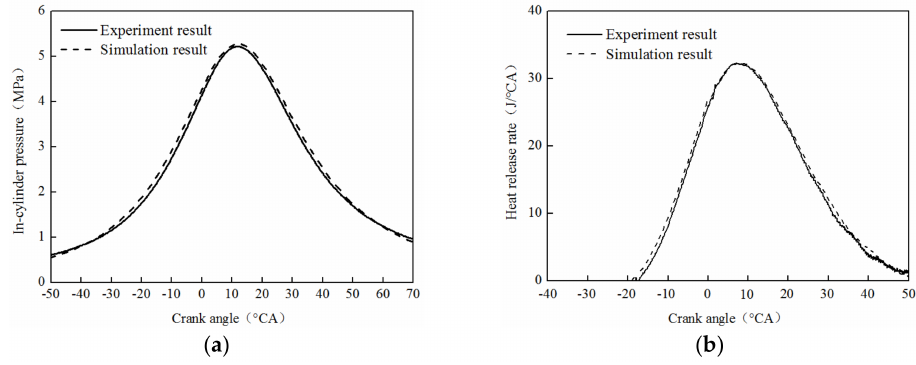
Figure 10. Combustion process comparison. ( a ) In-cylinder pressure; ( b ) Heat release rate.